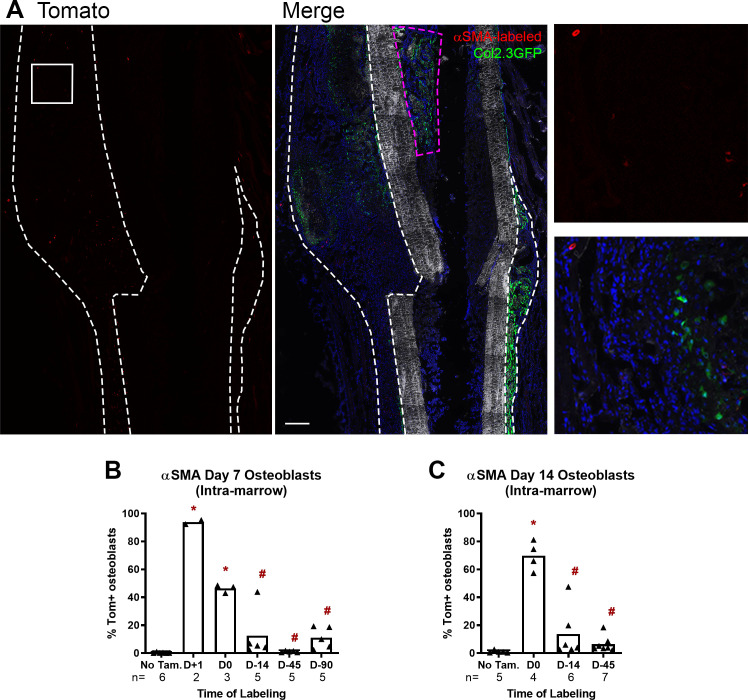
Minimal αSMACreER leakiness in fracture callus and contribution to endosteal bone formation.(A) Fracture histology of representative day 7 callus in an αSMACreER/Ai9/Col2.3GFP mouse never exposed to tamoxifen showing the red channel only and merged image. The magnified images show the boxed area. A small number of red cells are visible; however, very few colocalize with Col2.3GFP. Images show mineralized bone by dark field (gray) and DAPI+ nuclei in blue. Callus area is outlined by white dashed lines. Scale bar is 250 µm. (B) Contribution of αSMA-labeled cells to new Col2.3GFP+ osteoblasts in the bone marrow compartment (as indicated by pink box in A) in day 7 fractures and (C) in day 14 fractures. *p<0.05 compared to no tamoxifen control with ANOVA followed by Dunnett’s posttest. #p<0.05 compared to tamoxifen day 0 group. αSMA, alpha smooth muscle actin.